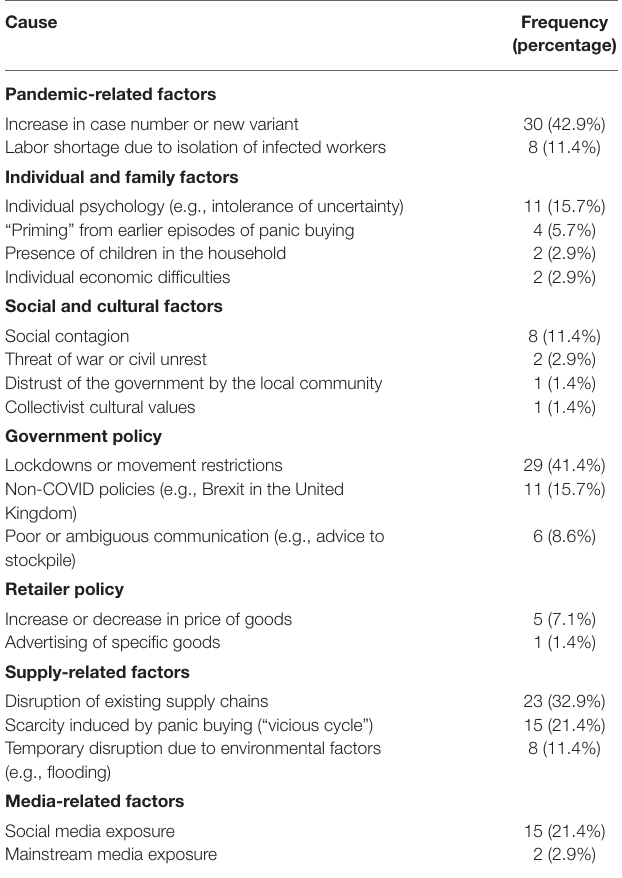
TABLE 4 | Causes for panic buying cited in news articles. TABLE 5 | Methods to reduce or control panic buying cited in news